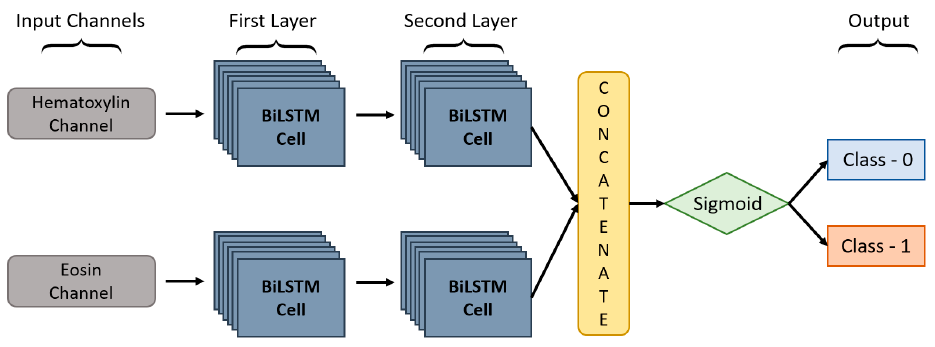
Figure 7. The structure of the proposed DC-BiLSTM Network.